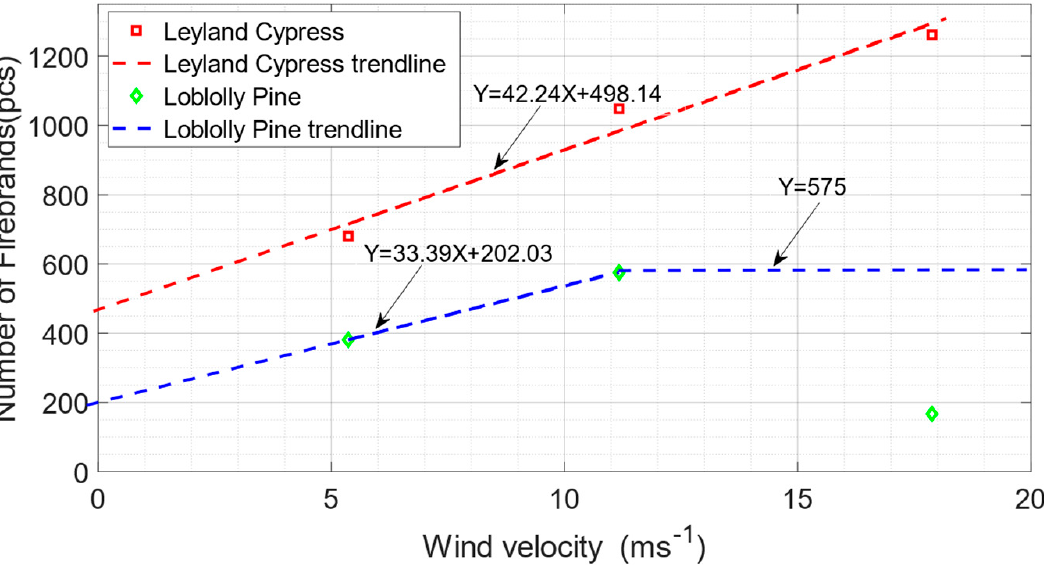
Figure 17. The experimental results of the number of firebrands collected at different wind speeds for loblolly pine and Leyland cypress vegetations. The experiment was conducted to collect all the firebrands generated in each tree burning [14].